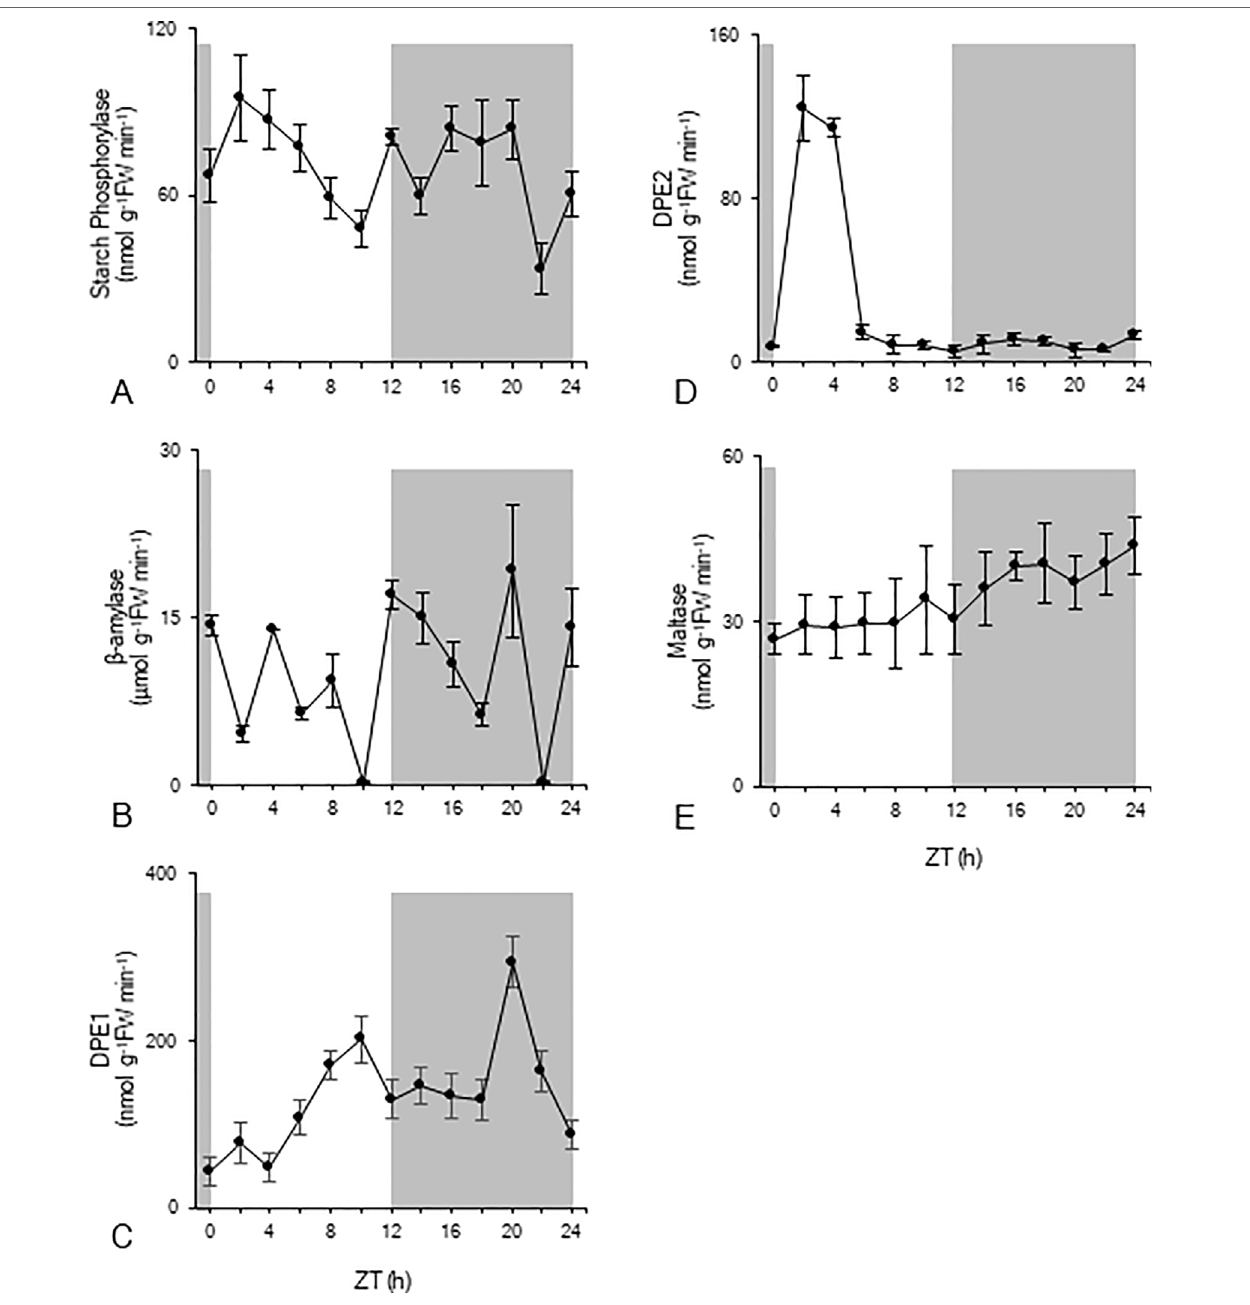
FigUrE 3 | Diel enzyme activity of starch phosphorylase (nmol g -1 FW min -1 , A ), β-amylase (µmol g -1 FW min -1 , B ), DPE1 (nmol g -1 FW min -1 , C ), DPE2 (nmol g -1 FW min -1 , D ), and maltase (nmol g -1 FW min -1 , E ) for young fully developed leaves of Phalaenopsis ‘Edessa’. The dark period is indicated in grey. Data are means ± SD (n =